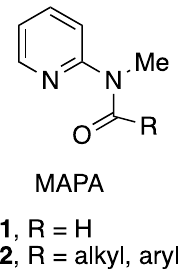
Figure 1. 2-Methylaminopyridine amides .